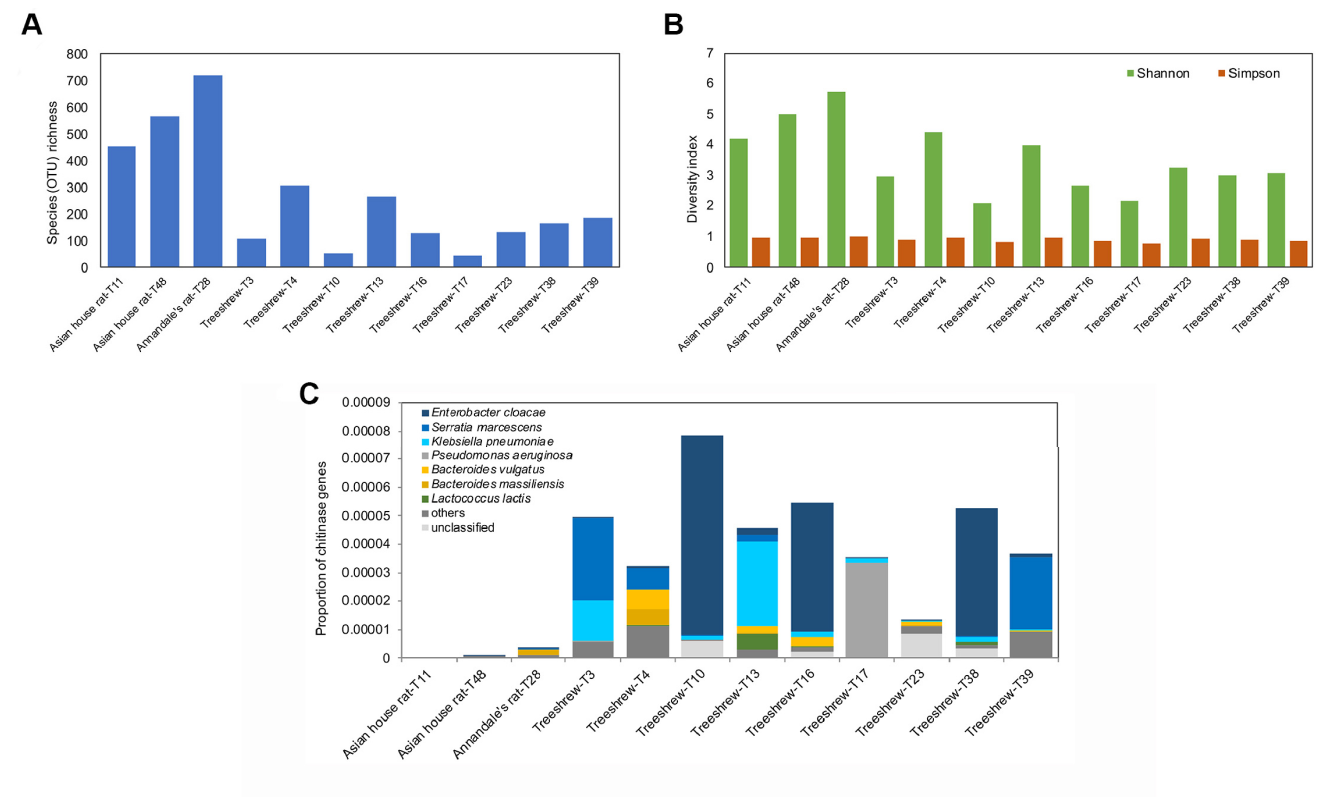
Fig 3. Microbiomes of the small mammals. (A) Microbial OTU richness. (B) Shannon and Simpson diversity indices. (C) Relative abundance of chitinases in gut microbiomes. The data underlying this figure are in S1 Data. OTU, operational taxonomic